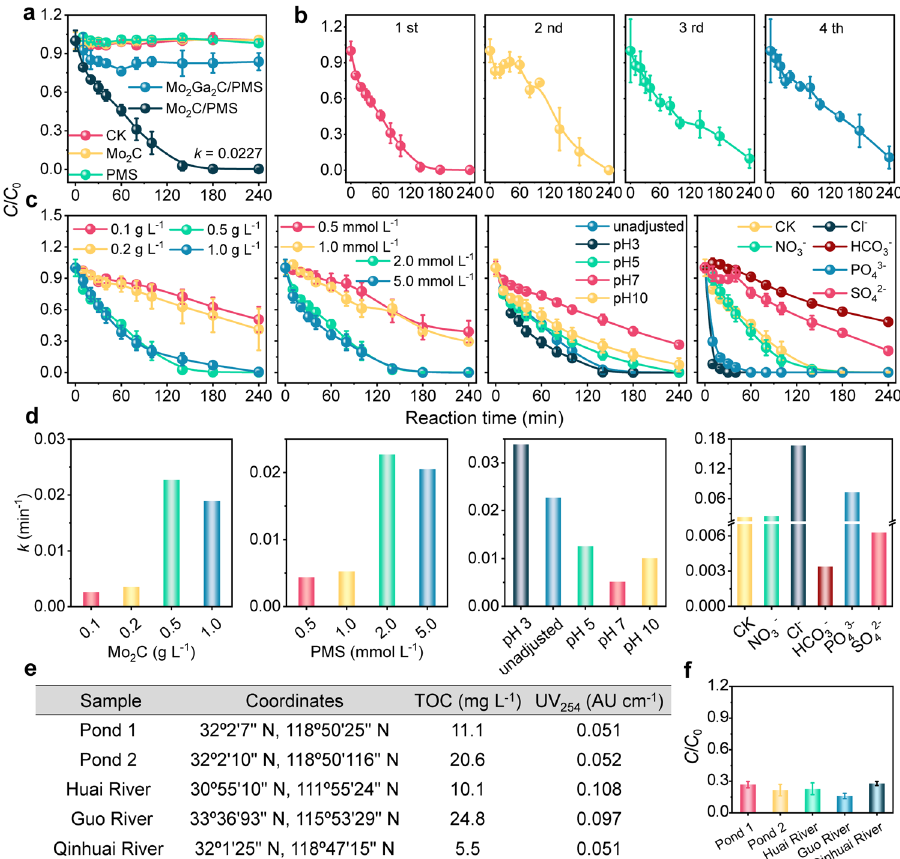
Fig. 2 Mo 2 C MXene activated peroxymonosulfate (PMS) for bisphenol A (BPA) degradation. a Degradation kinetics of BPA in Mo 2 C MXene/ PMS system. b Reuse ef fi ciency of Mo 2 C MXene, CK means the control treatment without Mo 2 C MXene and PMS; c The in fl uence of Mo 2 C MXene and PMS dosage, initial solution pH, and inorganic anions on Mo 2 C MXene/PMS system. d The reaction rate constants obtained by pseudo- fi rst-order kinetic fi tting, CK means the control treatment without inorganic anions. e The collection coordinates of fi ve actual water bodies and their total organic carbon (TOC) content and UV 254 indicators. f Degradation percentages of BPA in fi ve actual water bodies. The error bars represent the standard deviation (SD). Conditions: Mo 2 C MXene = 0.5 g L − 1 , Mo 2 Ga 2 C = 0.5 g L − 1 , [PMS] 0 = 2.0 mmol L − 1 ,